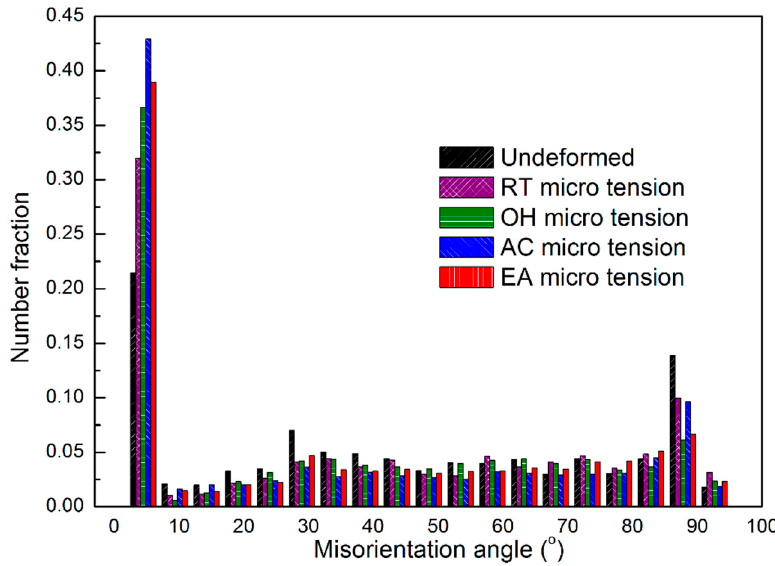
Figure 6. Pixel-to-pixel misorientation angle distributions of the fractured AZ31 samples for the different tested configurations.